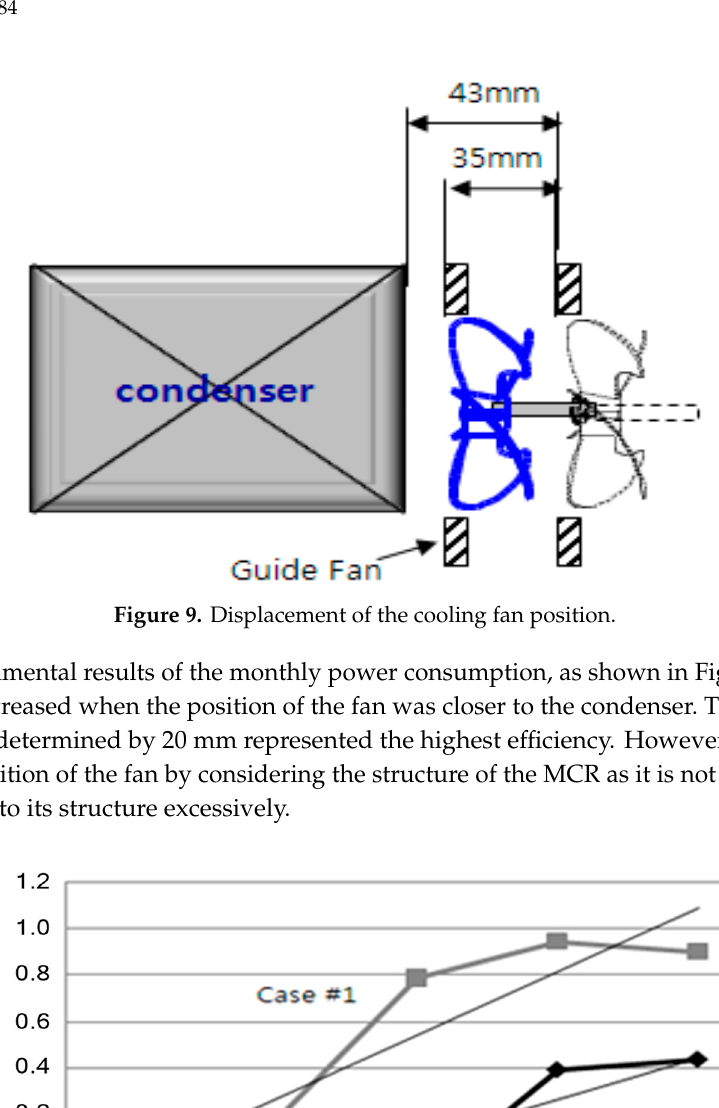
Figure 10. Monthly power consumption for various lengths between the condenser and the fan.